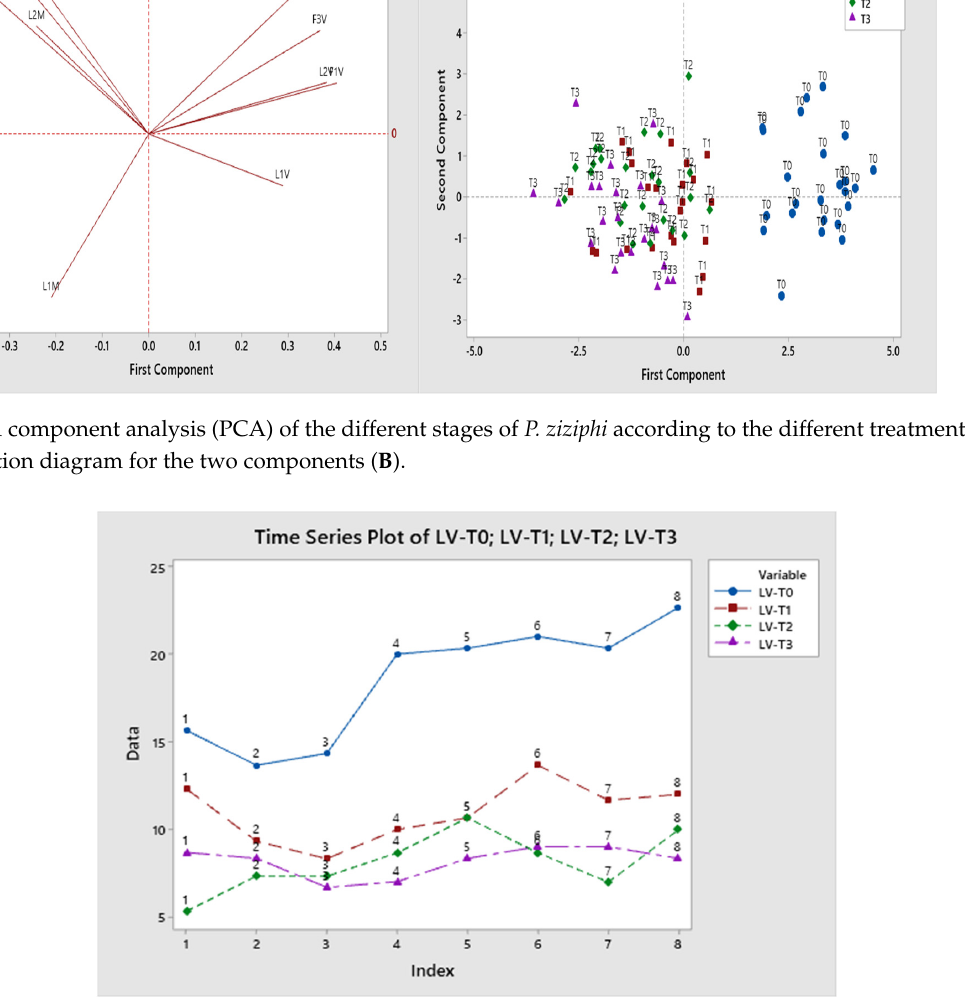
Table 1. Relationship between the different stages of P. ziziphi.